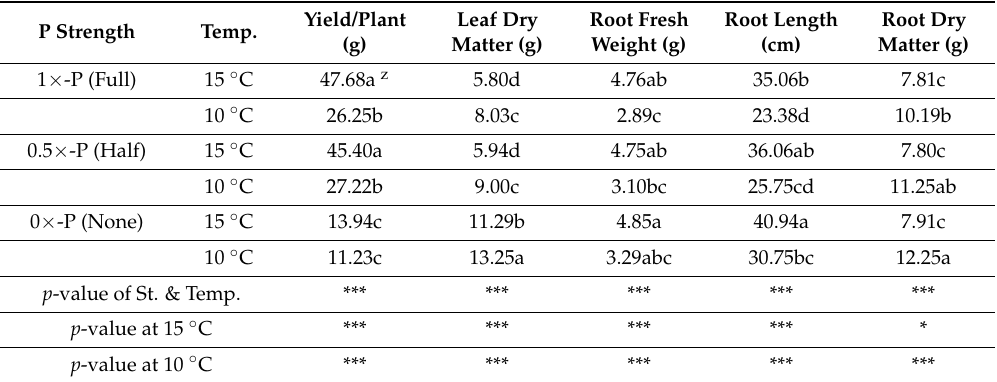
Table 4. Plant yield, leaf dry matter, root fresh weight, root length and root dry matter of red romaine lettuce at harvest day (28 days after treatment).